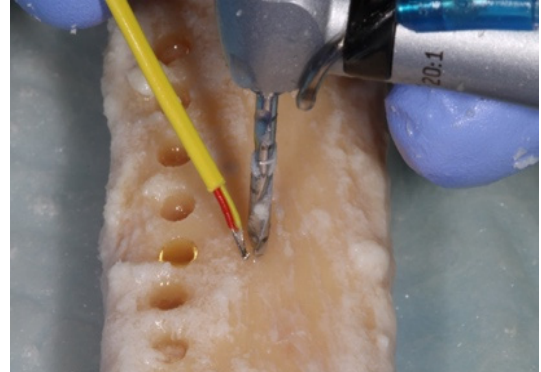
Figure 6. The initial temperature of the bone was recorded with the use of the K-Type thermocouple holding the thermocouple probe against the bony outer cortical layer ( Step 1 ). Each osteotomy was completed starting with the pilot drill with external irrigation at each of the 800, 1000, or 1200 RPM drilling speeds ( Step 2 ), (Figure 7).